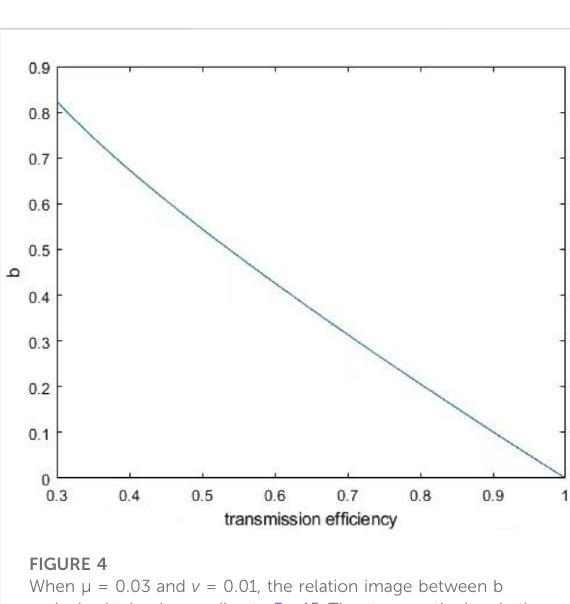
FIGURE 4 When μ = 0.03 and v = 0.01, the relation image between b and ŋ is obtained according to Eq. 15. The stronger the loss in the channel, the higher the value of b (the probability that Eve can block a single